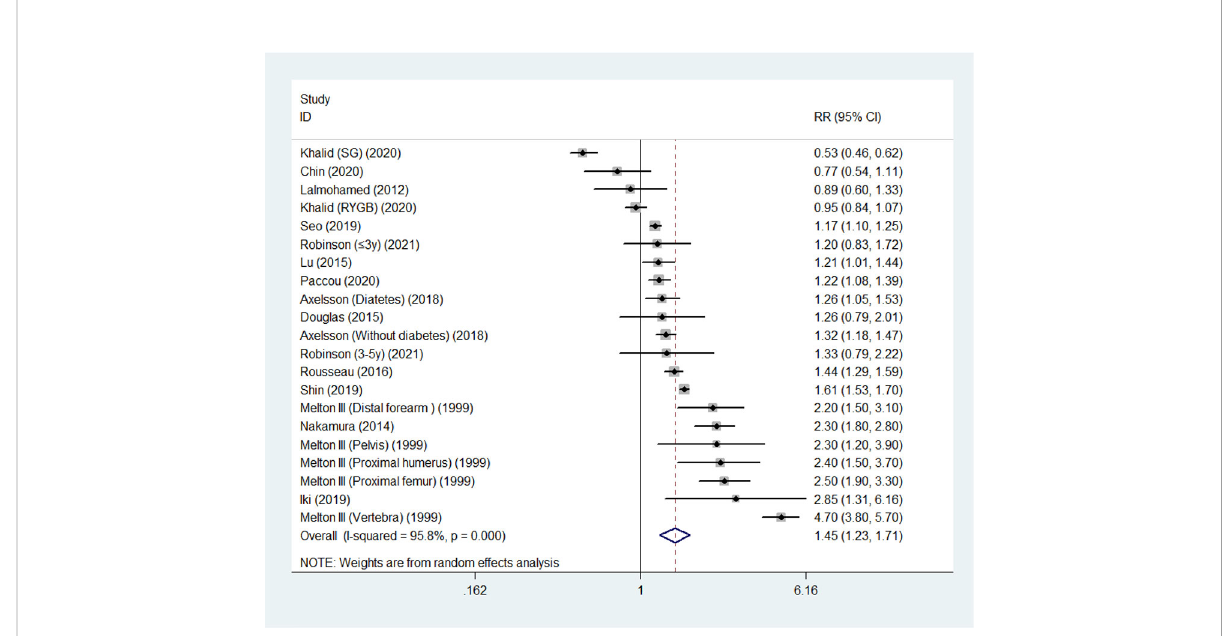
FIGURE 2 Relative risk (RR) for association between gastric surgery and fracture